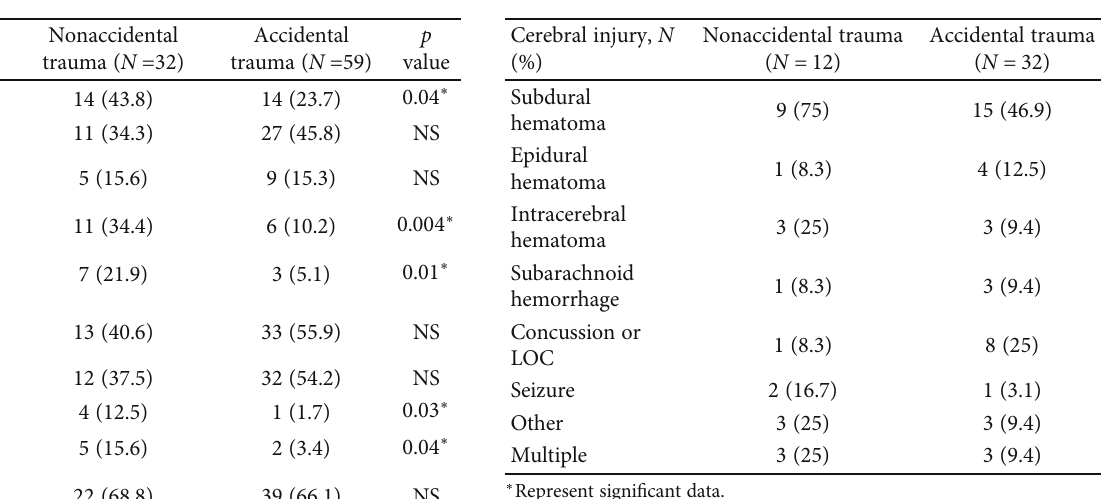
Table 2: Comparison of nonaccidental and accidental trauma by general injury pattern.